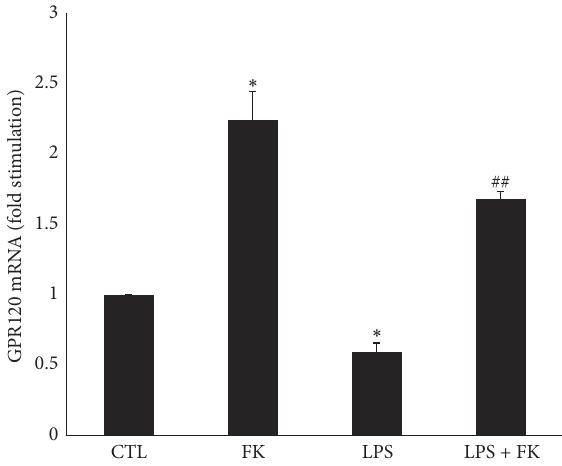
Figure4:mRNAexpressionofGPR120indifferentiated3T3-L1cells treated with LPS in the presence or absence of FK. Differentiated 3T3-L1 cells were treated as described in Materials and Methods under the following conditions: CTL, 10 𝜇 M FK, 1 𝜇 g/mL LPS, and LPS+FK.TheresultsareexpressedasmRNAlevels(foldstimulation over CTL set to 1) and are the means ± SEM of 3 independent experiments. Data were analyzed using 𝑡 -test for unique sample and paired 𝑡 -test; ∗ 𝑝 < 0.05 versus CTL; ## 𝑝 < 0.01 versus LPS.